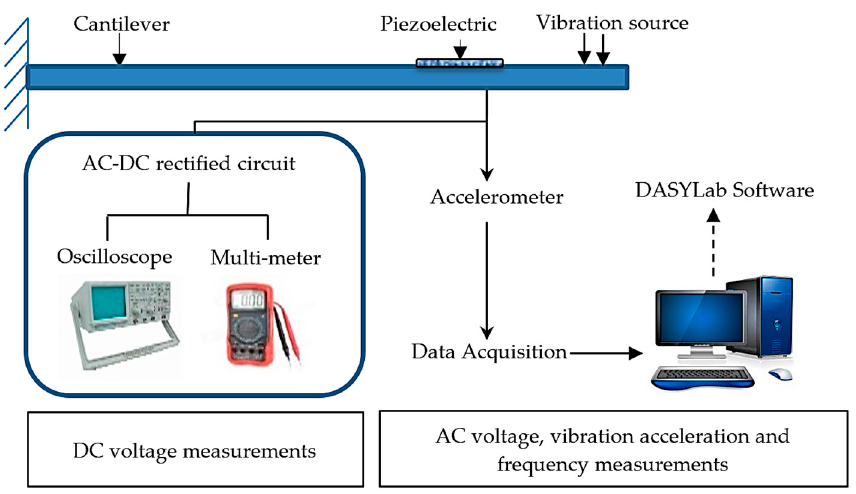
Figure 8. Energy harvesting experimental setup.